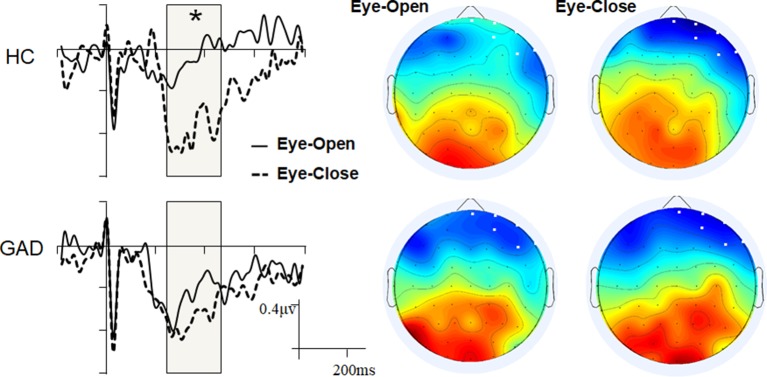
Grand event-related potentials (ERPs) and scalp topology. The ERP waveforms were averaged across the six selected electrodes with the highlighted significant time window.